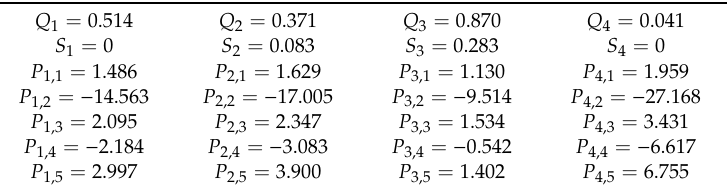
Table 3. Convergence condition